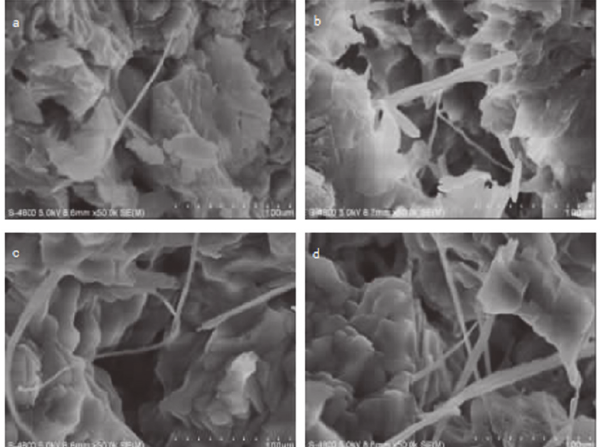
Figure 2: The microstructures of some specimens (the mixing amount of multiple-wall carbon nano-tubes in (a) - (d) is 0.05%, 0.1%, 0.2% and 0.25%